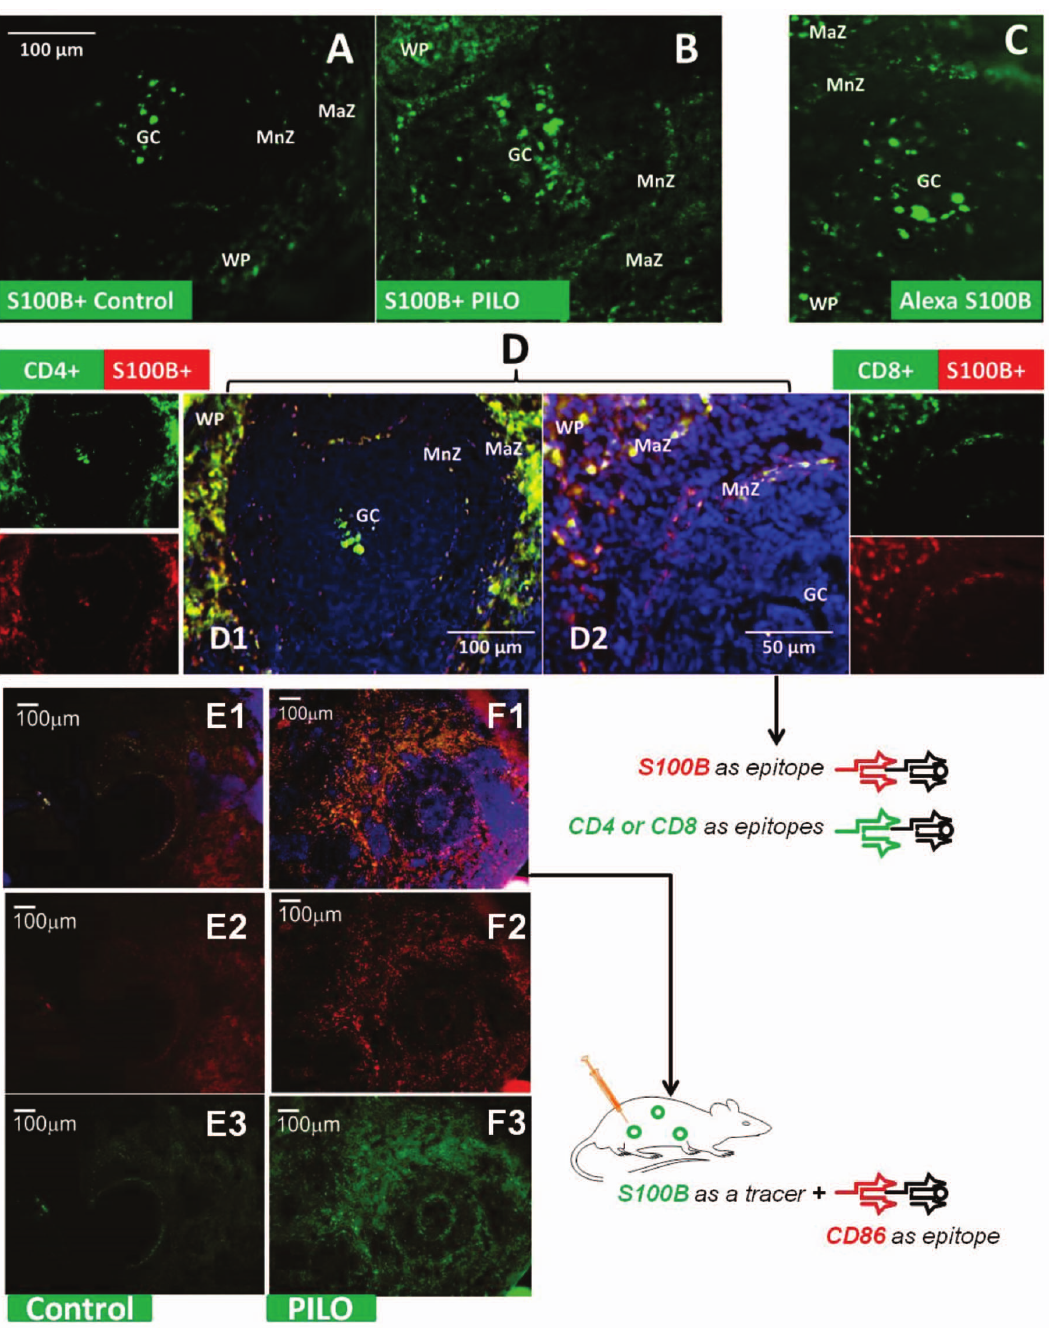
Figure 5. Splenic S100B-positive cells change in both number and morphology following pilocarpine-induced seizure. S100B positive cells can be viewed within splenic follicles both in an unmanipulated animal ( A ), as well as following simulation of BBBD via IV injection of Alexa Fluor 488-labeled S100B ( B ) and BBBD from pilocarpine administration ( C ). The pattern of staining is preserved in all 3 conditions, however, staining is clearly augmented in BBBD simulation and to a much greater degree in actual induced BBBD. S100B-labeled lymphocytes and dendritic cells can be observed in all regions of the splenic follicle. Note that the morphology of labeled cells also appears to change with induction of BBBD in ( C ), where cells appeared to have a more dendritic and interconnected staining pattern than in other conditions. The identity of these cells was verified via the immune cell markers, CD4 and CD8 immunostaining ( D1–D2 ); S100B + and CD4 + /CD8 + double positive cells are again found throughout the follicle, with emphasized staining in the marginal zone vs other areas. Injection consisted of AlexaFlour 488-tagged S100B at a concentration of 0.10–0.12 ng/ mL introduced via tail vein and allowed to circulate 2–3 hrs prior to tissue harvesting. For induced BBBD, the animal was treated with pilocarpine and spleen was removed prior to onset of status epilepticus. Sections in A and C were treated with mouse anti-S100B antibody (Ab) and donkey anti- mouse 2 u Ab conjugated to FITC (Jackson). In D1–D2 , sections were treated with rabbit anti-S100B Ab and donkey rabbit 2 u Ab conjugated to Texas Red (Jackson) and rat anti-CD4 or CD8 antibody and mouse anti-rat 2 u Ab conjugated to FITC (Jackson). DAPI was added as a nuclear stain. In E–F , sections shows rats injected with S100B tracer in control ( E1–E3 ) and pilocarpine administrated rats ( F1–F3 ). Co-localization of S100B + CD86 (F1) and high individual staining of CD86 + ( F2 ) in pilocarpine compared to controls E1 and E2 indicates that activated immune cells capture S100B. The